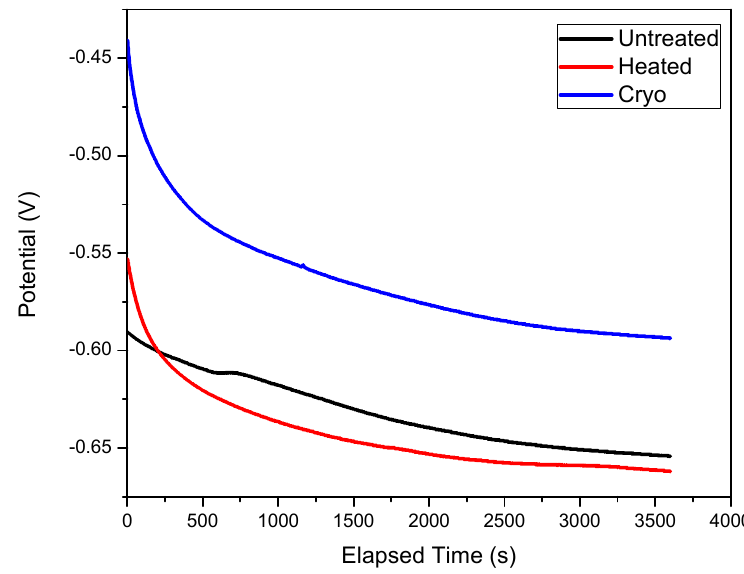
Figure 6. Evolution of the open circuit potential over time. Figure 7 represents the polarization curves of the investigated surfaces. Based on Tafel extrapolation [46], the main corrosion parameters were extracted from Figure 6 and presented in Table 1, as frequently reported [47]. Heated specimens exhibited a more electropositive value of the corrosion potential (E i = 0) compared to the uncoated and cryo specimens, indicating that the corrosive solution had less influence on their surfaces. The cryo specimen had a more electronegative corrosion potential, showing poor corrosion resistance to NaCl attack. Lower corrosion current density (i corr ) and higher polarization resistance (R p ) values were observed for heated specimens, showing